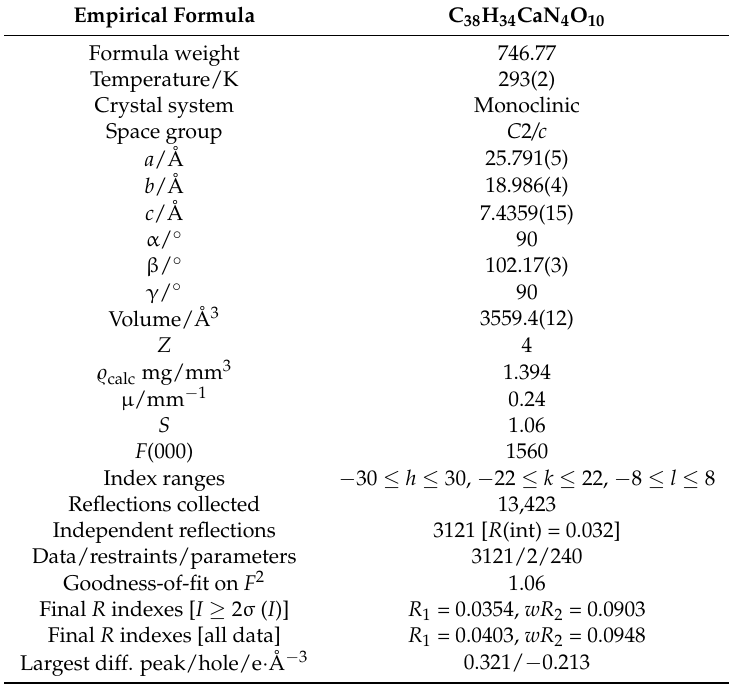
Table 2. Crystallographic data and structure refinement for [CaL 2 (H 2 O) 2 ] n